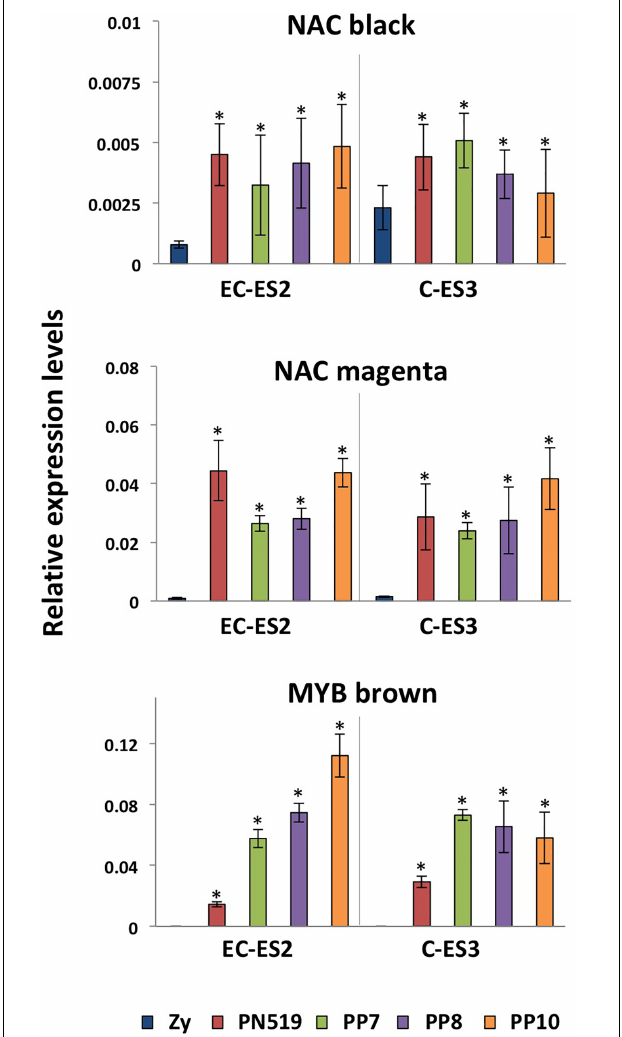
FIGURE 6 | Expression patterns of regulatory hub genes. Quantitative analysis of transcript levels for genes that are differentially expressed in zygotic embryos (Zy) at early cotyledonary (EC) and cotyledonary stages (C) versus four somatic lines, PN519, PP7, PP8, and PP10, at pre-cotyledonary opaque (ES2) and cotyledonary (ES3) stages. Genes included in the analysis were those encoding NAC black, NAC magenta, and MYB brown in reference to the co-expression module where the TF is included. Each value is the mean ± standard deviation of three biological replicates. Asterisks indicate significant differences between zygotic and somatic samples calculated using Student’s t -test ( P < 0.05). The expression level for all genes was normalized using Actin-7 as a